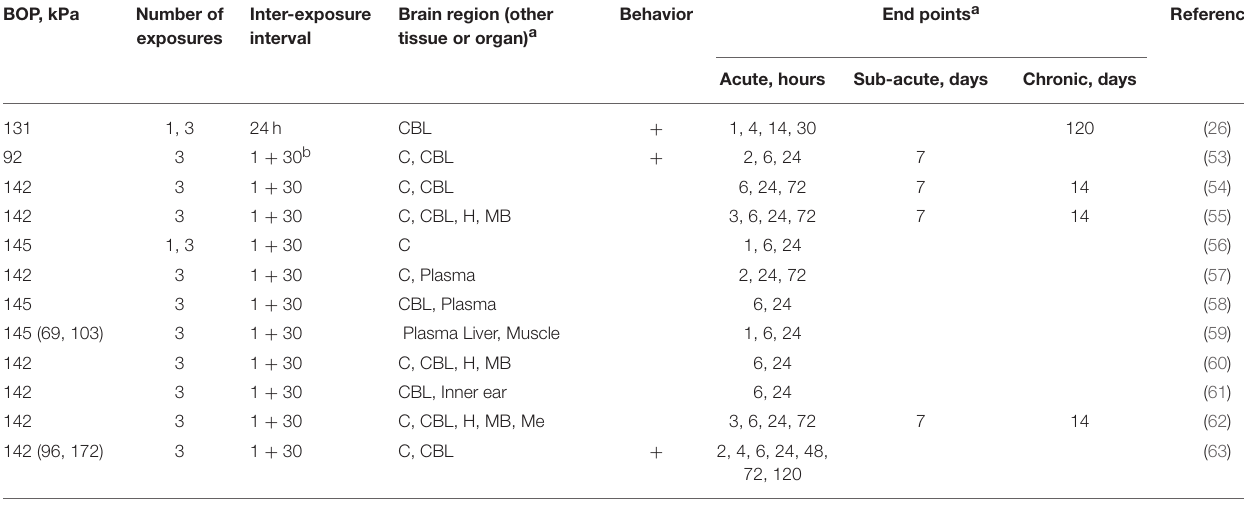
TABLE 3 | The summary of experimental variables (exposure conditions: BOP, number of exposures and inter-exposure interval, analyzed brain region, behavioral testing and end points) in studies using C57BL/6J mice. BOP,